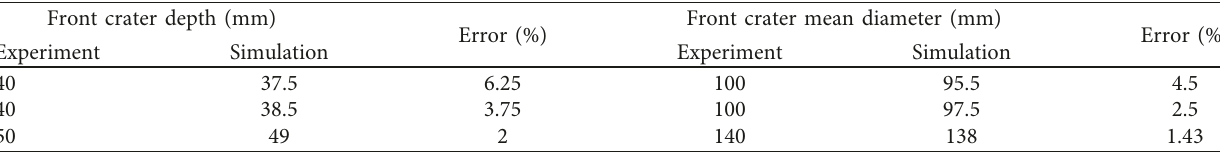
Table 4: Comparison of experimental [29] and simulated results for the front crater damage (0-3-317). Front crater depth